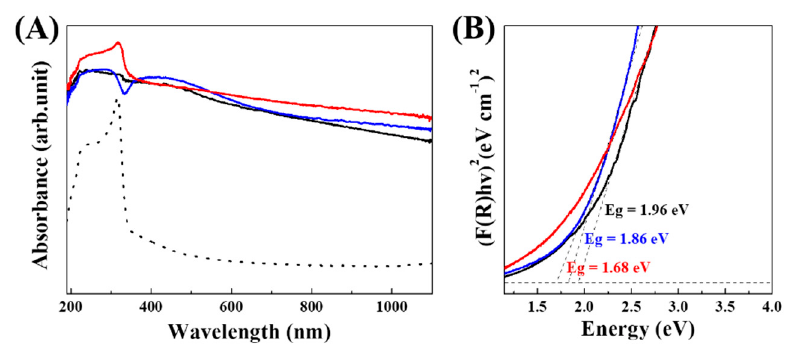
Figure 6. ( A ) UV-vis diffuse reflectance spectra of Ag powder (dot line) and Ag@LDOs and ( B ) Kubelka-Munk-transformed reflectance spectra of Ag@LDOs (black line: Ag@LDO400, blue line: Ag@LDO500, and red line: Ag@LDO600). No offset was set among graphs. The band gap of AgNPs in LDO matrix was calculated by Kubelka-Munk conversion.